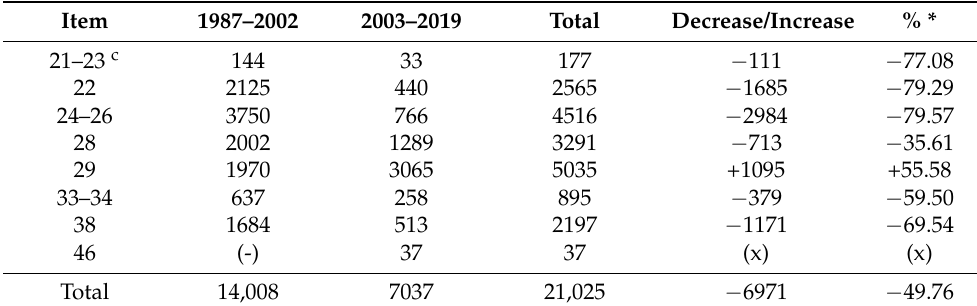
Figure 5. Development of the number of occupational diseases in Slovakia (1987–2019). Table 3. Comparison of occupational diseases reported in the last 32 years.